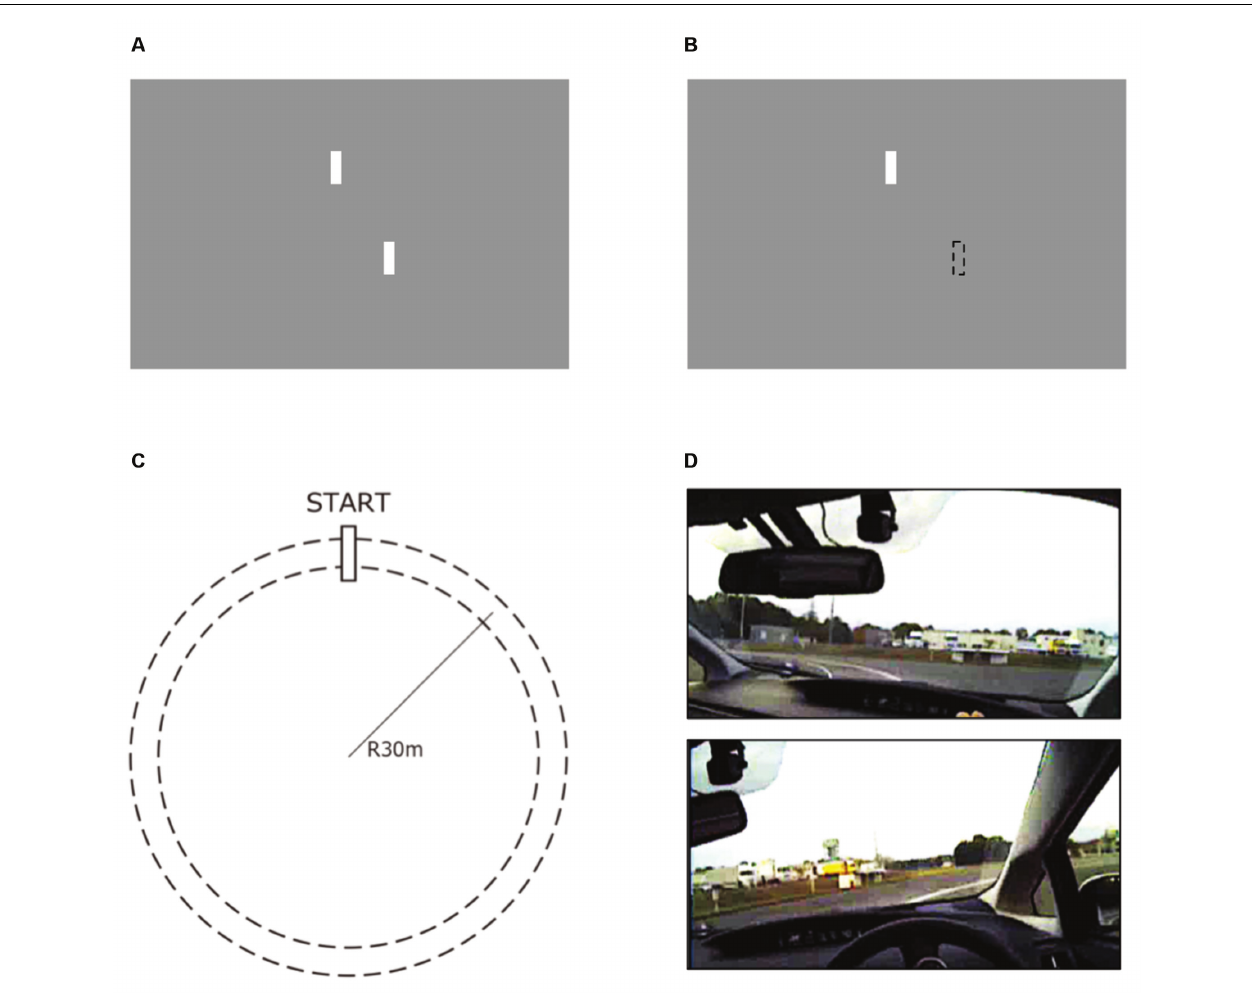
FIGURE 1 | Test conditions of the tracking task (A,B) and driving task (C,D) . In the tracking task, the target and cursor are the upper and lower white bars, respectively. The target moved horizontally and unpredictably. Each participant’s task was to track the center of the target with the center of the cursor. (A) The visible cursor condition (VC), where the cursor was always visible, and (B) the invisible cursor condition (IC), where the cursor was invisible, forcing the participant to predict the position of the cursor. In the driving task, participants were instructed to drive on a circular course (C) while maintaining a constant speed and distance from the inner edge of the lane. In the counter-clockwise circling condition (CC: the upper figure of D ), the distant part of the course lines was usually visible. In the clockwise circling condition (CW: the lower figure of D ), the distant part of the course lines was